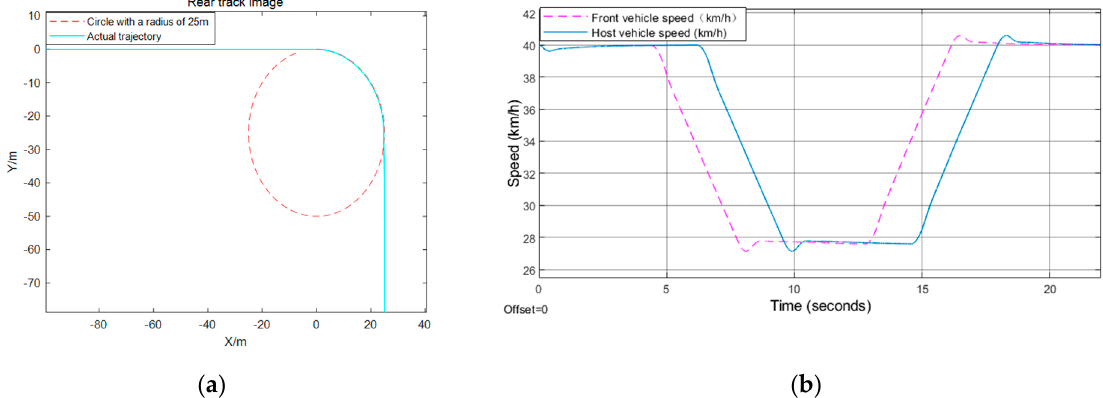
Figure 7. Turn right test result: ( a ) rear track image; ( b ) front and rear vehicle speed.